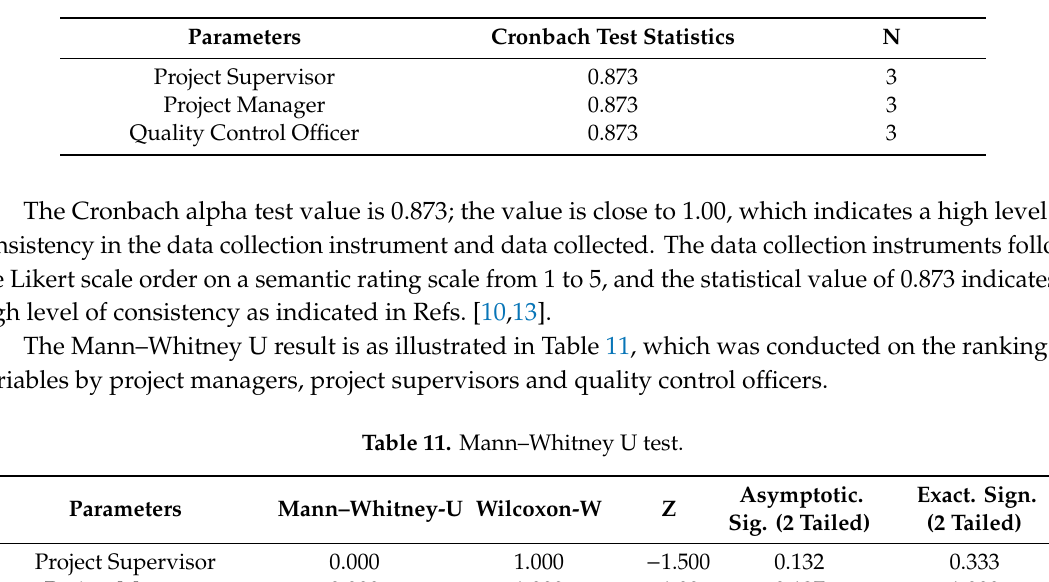
Table 10. Cronbach alpha reliability test.